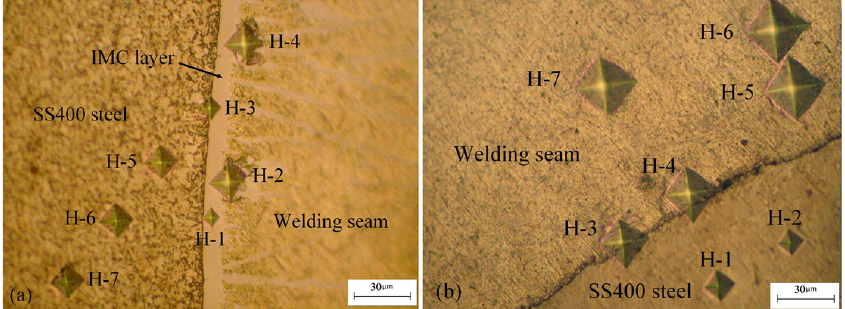
Figure 4. ( a ) Microstructure hardness is tested in intermetallic layer zone A in Figure 2; and ( b ) without IMC layer zone B in Figure 2.